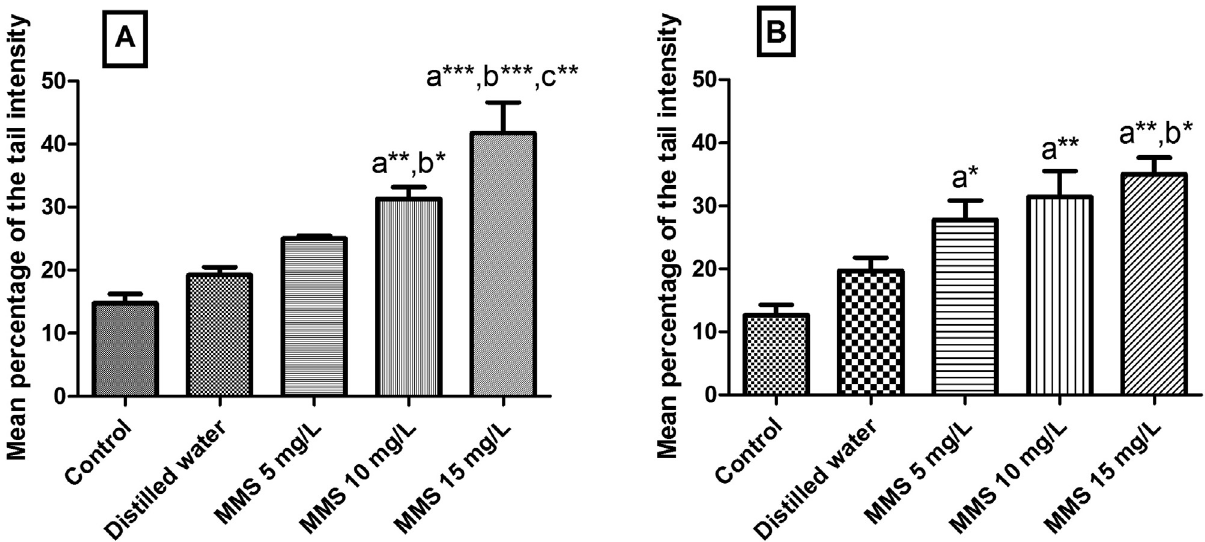
Figure 3 - Mean percentage of tail intensity of nucleoids from Phaseolus vulgaris L. exposed to different concentrations of methyl methanesulfonate (MMS). A )accessionGF004. B )accessionGF007.Thedataarerepresentedasmeans (cid:4) SEM.Control=seedsnotexposedtoMMSortodistilledwater. a Significant in relation to control. b Significant in relation to distilled water group. c Significant in relation to MMS 5 mg/L group. One-way ANOVA fol- lowed by Tukey test (* p <0.05; ** p <0.01; *** p